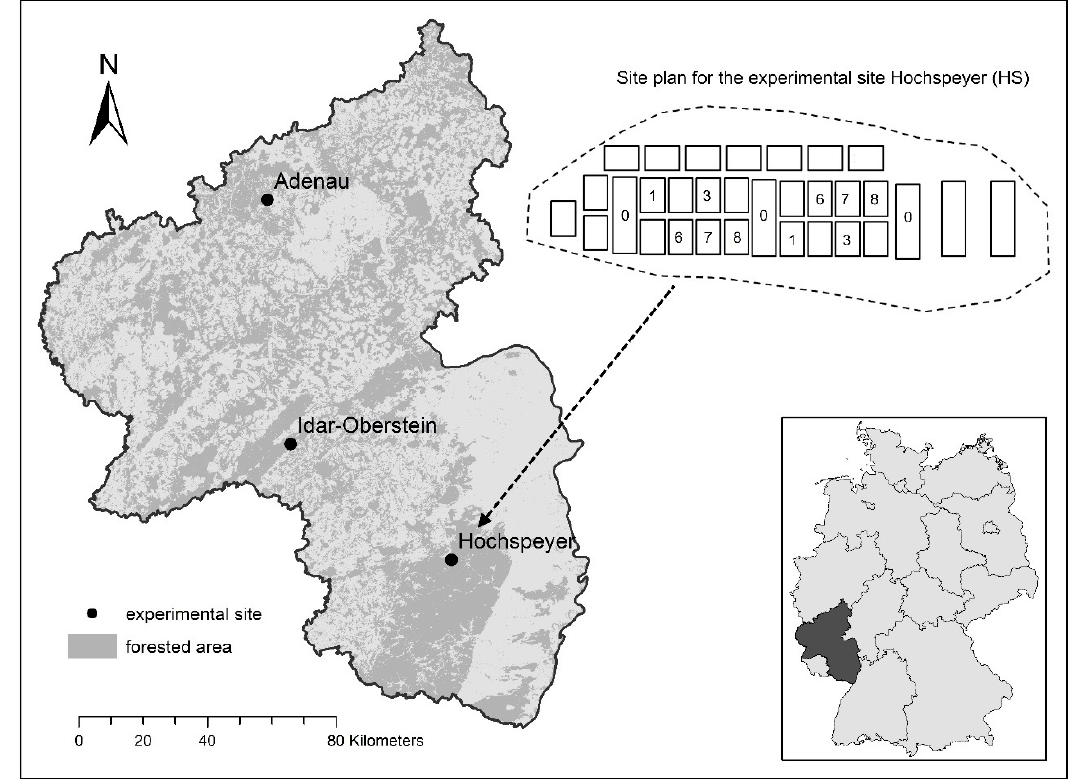
Figure 1. Location of the three experimental sites Adenau (AD), Idar-Oberstein (IO) and Hochspeyer (HS) in Rhineland- Palatinate over a map of the forested area (dark gray). The location of the state Rhineland-Palatinate is shown on the map of Germany in the down right corner. In the upper right is a site plan with plot arrangement of the different liming treatments (LT) of the experimental site HS. For more Information about the numbered treatments, which are part of this article, see Table 2. More information about the experimental sites is documented in Table 1.